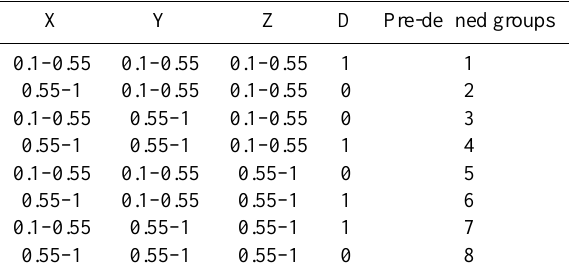
Table 1. Pre-defined groups in the theoretical data set.